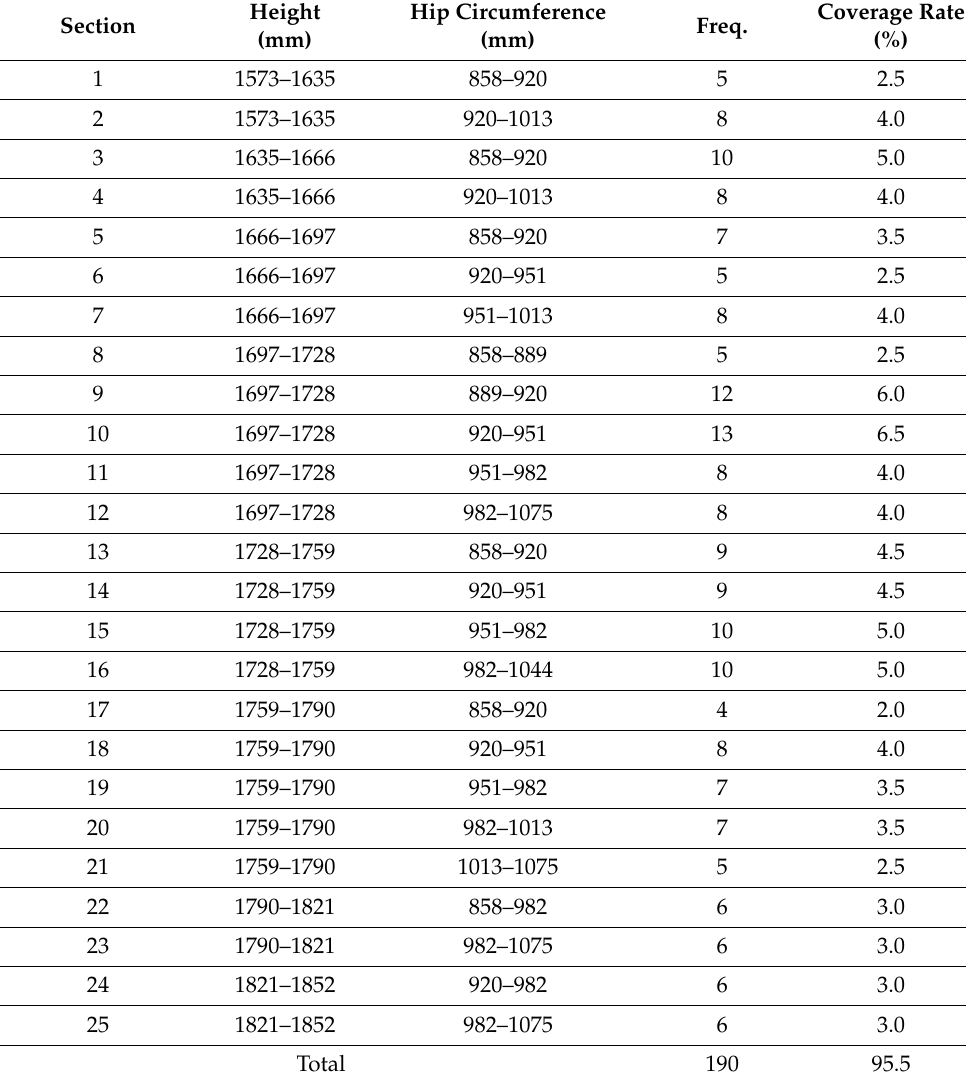
Table 6. Results of primary cross-tabulation